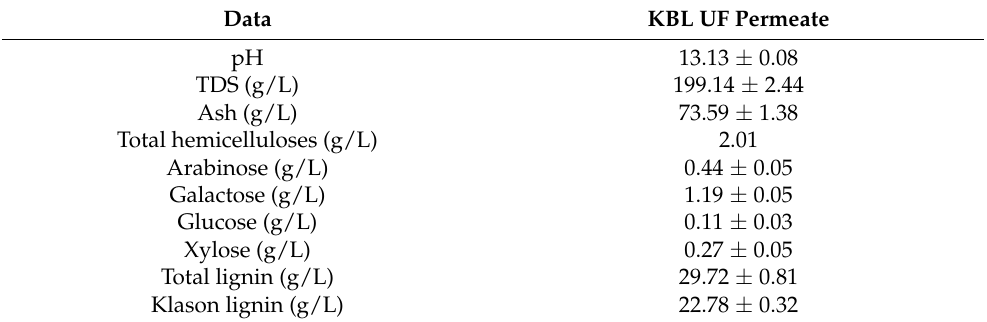
Table 1. Feed solution composition and properties. The analyses were performed in triplicate.